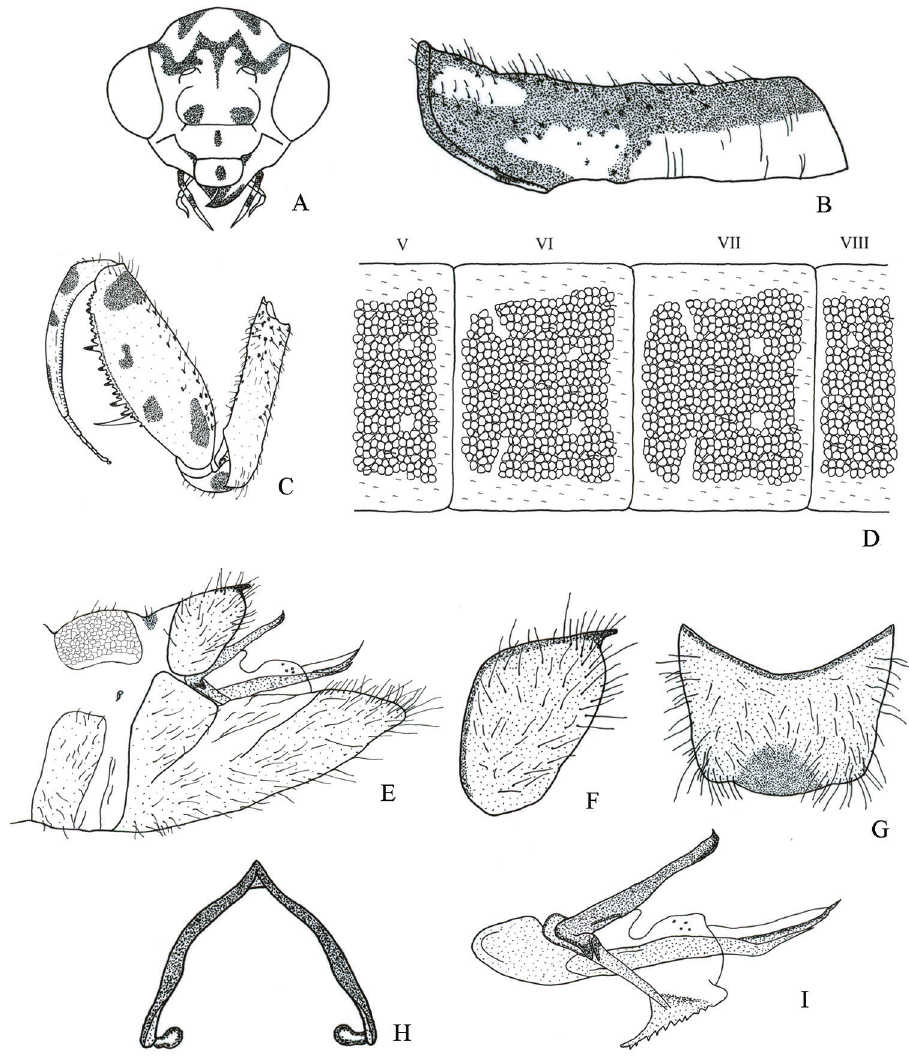
Figure 10. Structures of the male of Nolima victor . A head, frontal B prothorax, lateral C left foreleg, lat- eral D abdominal terga V–VIII, dorsal E external terminalia, lateral F left ectoproct, lateral G ectoprocts, dorsal H gonarcus, dorsal I internal terminalia, lateral. midline (Fig. 10B). Forecoxa with bristle-bearing chalazae on ventral, lateral, and dorsal surfaces; chalazae bases colored (Fig. 10C). Forefemur with four marks on lateral sur- face (Fig. 10C), mesal surface with circular mark; dorsal surface with dark brown circu- lar marks at setal bases (Fig. 10C). Foretibia with basal, medial, and apical dorsolateral marks (Fig. 10C). Meso- and metapleuron with pigmentation on anepimeron, anepis- ternum, katepimeron, katepisternum, and meron. Middle and hind leg with dark